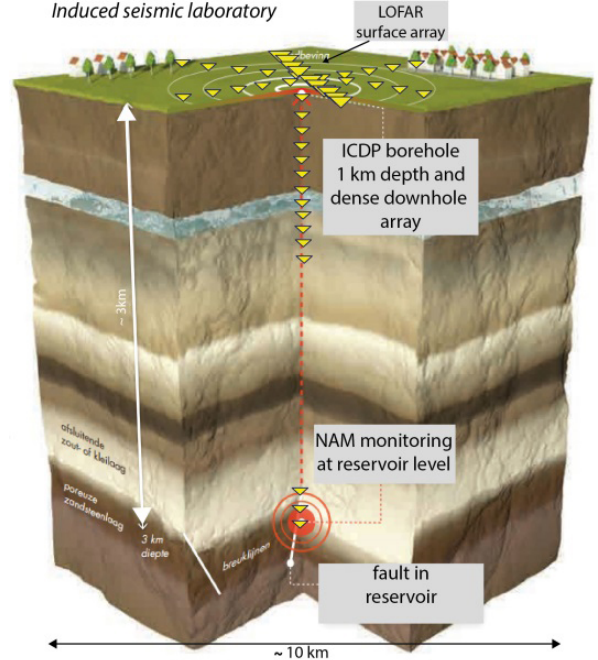
Figure 3. Schematic representation of a dense downhole array of seismic sensors coupled with a LOFAR surface array. Poten- tial monitoring at the reservoir level falls outside the scope of